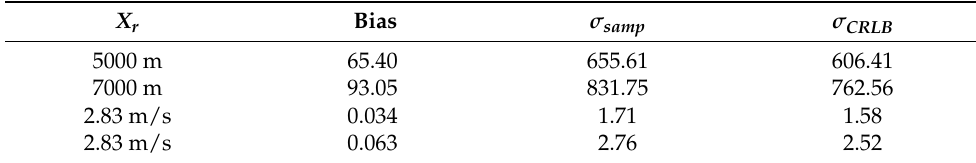
Table 4. Performance of the estimator of the reduced state vector.